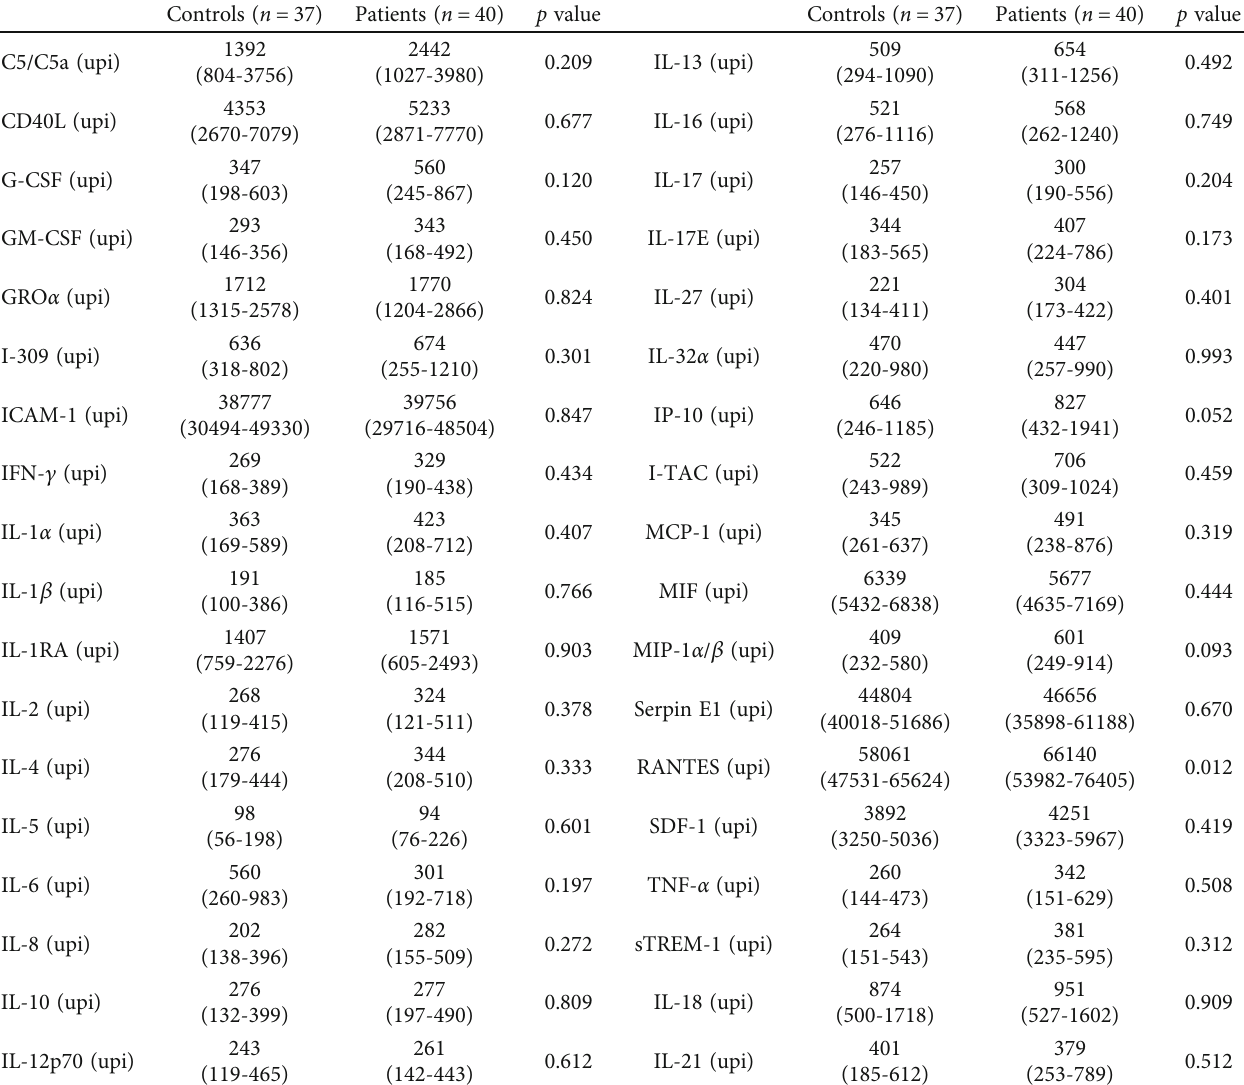
Table 4: Baseline levels of in fl ammatory